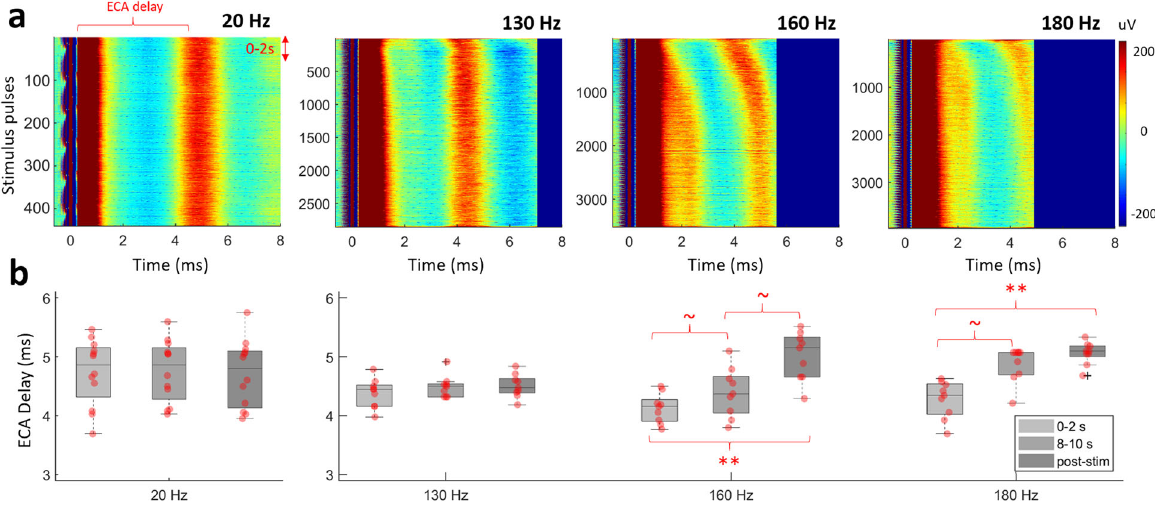
Fig. 6 Inter-pulse evoked activity shows adaptation only with high-frequency stimulation. a The representative aligned raw data with respect to the stimulus pulse for 130, 160, 180, and 20 Hz stimulation (0.5 ms pre-onset, up to 8 ms is shown). b The ECA delay comparison in the 0 – 2, 8 – 10, and after 22 s demonstrate the differences in adaptation between 130, 160, 180 ( n = 9), and 20 Hz ( n = 13) stimulations. The ECA delay, which denotes the delay of the fi rst evoked peak, was consistent throughout the 20 Hz stimulation period, indicating no adaptation. The fastest adaptation was with 130 Hz, settling after 2 s. On each box in the boxplots, the central mark indicates the median, and the bottom and top edges of the box indicate the 25th and 75th percentiles, respectively. The whiskers extend to the most extreme data points not considered outliers, and the outliers are plotted individually using the “ + ” symbol. The individual data points are also plotted as red circles. ~ denotes p value <0.09, ** denotes signi fi cance <0.01.